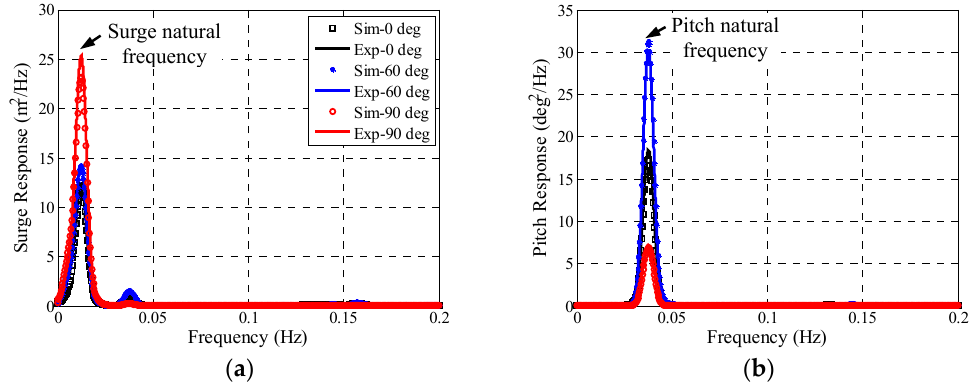
Figure 16. Comparisons of ( a ) surge and ( b ) pitch PSD in three wave headings.